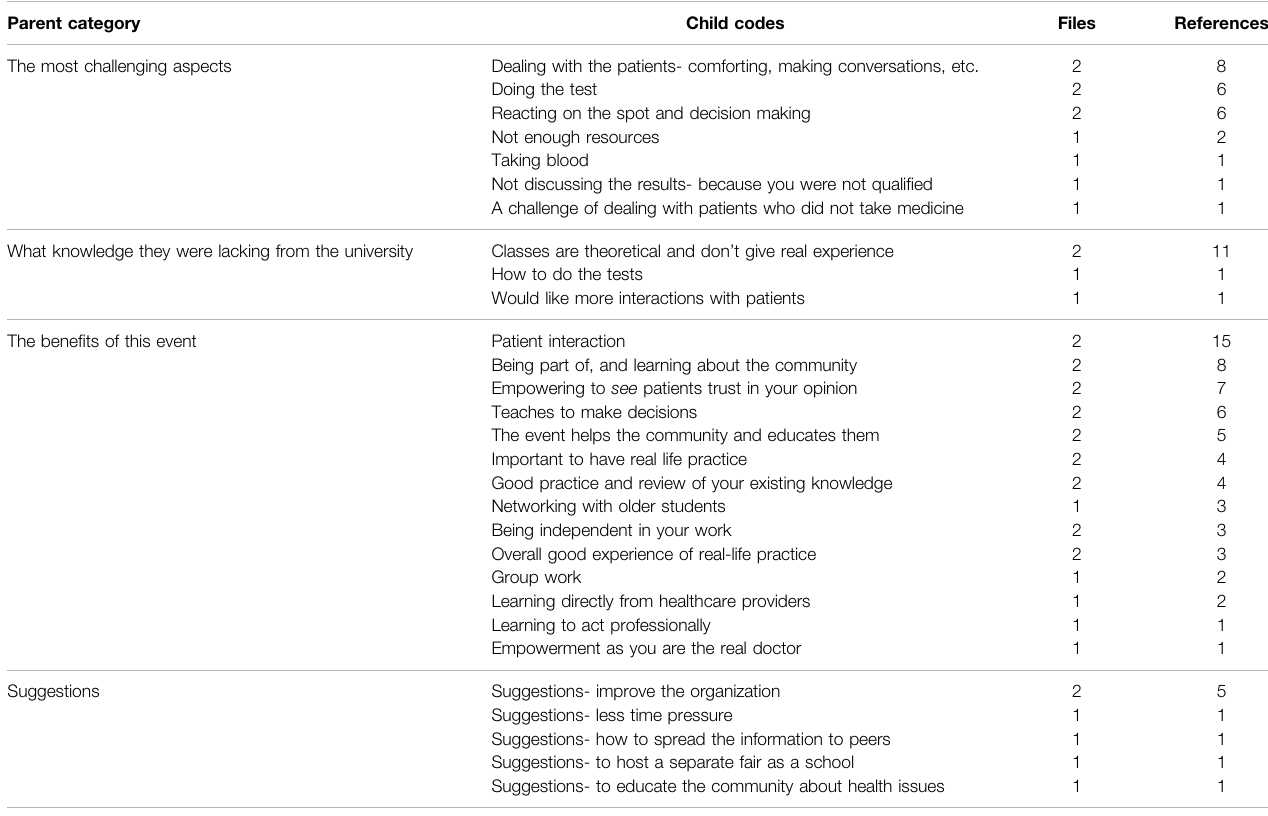
TABLE 4 | Organizing the initial codes into a parent-child. Parent